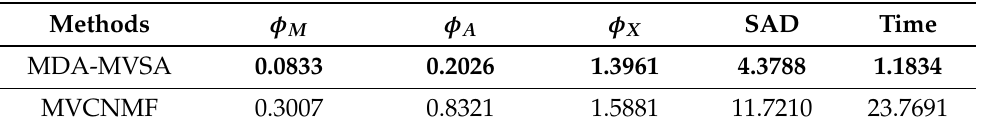
Figure 8. False color composition of the considered Samson subimage. Table 8. Performance and processing time (seconds) obtained by our proposed MDA-MVSA method and MVCNMF on the considered Samson